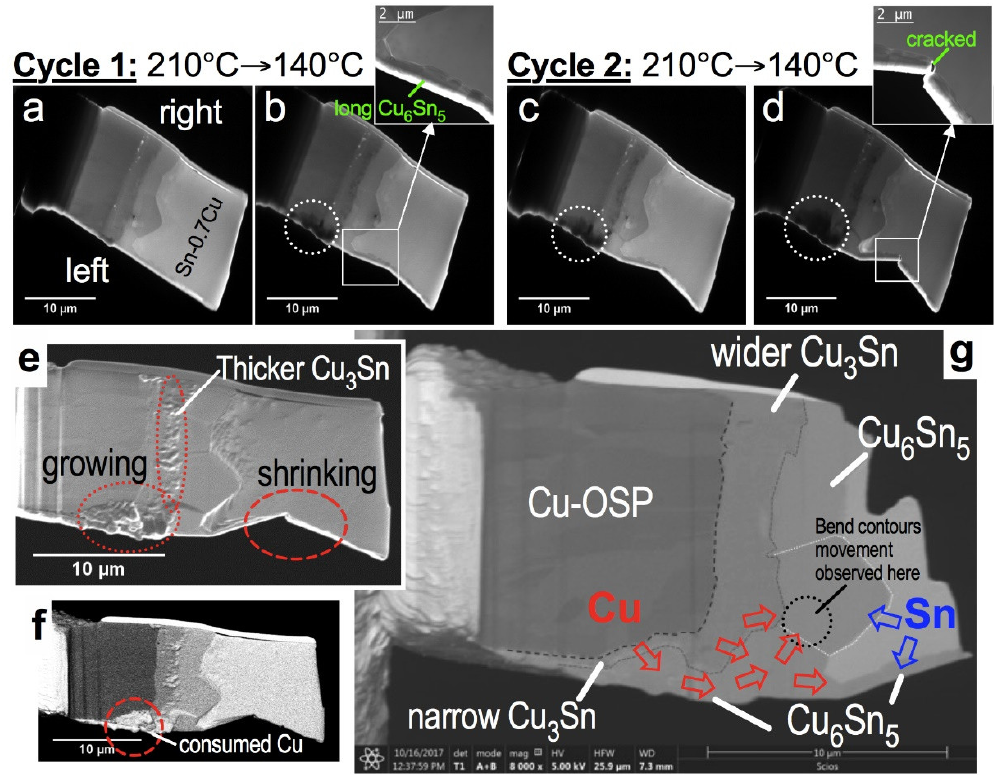
Figure 7. The morphology evolution of sample. ( a – d ) Low magnification bright-field plasmon-filtered TEM images; ( e ) secondary and ( f , g ) backscattered SEM images of the lamella sample after the in-situ experiment; ( g ) analysis of post-thinned FIB lamella sample.